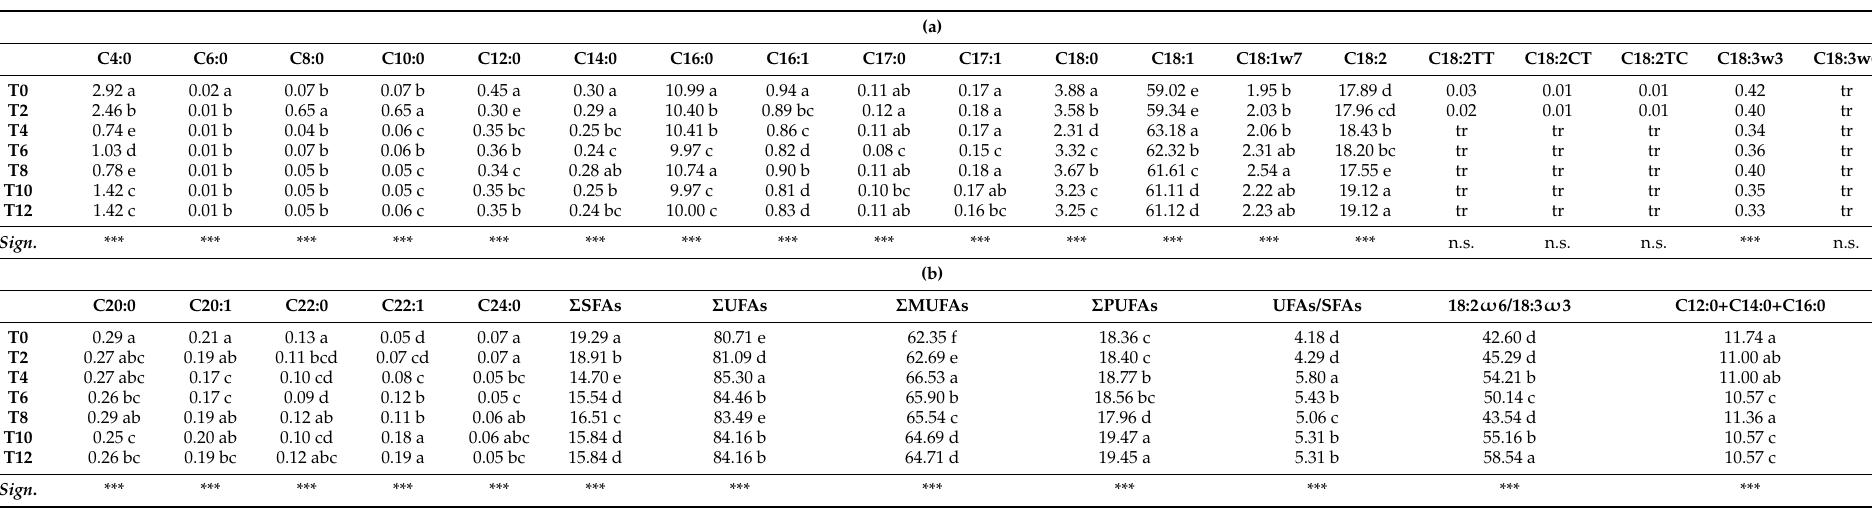
Table 7. Fatty acid methyl esters found in the modified recipe Cantuccini. One-way ANOVA, means ± SD (of six replicates) in the same column followed by a different letter are significantly different according to Tukey’s test; *** p 0.001; n.s., not